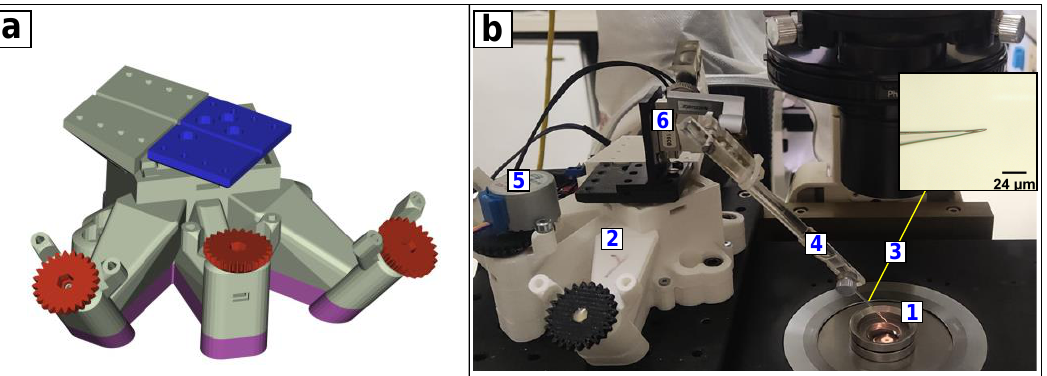
Figure 1. Translation motion stage integrated with microscope set-up for fluorescence calcium imaging. ( a ) Colour-coded CAD of motion translation stage, 3D printed in few parts: a base (purple), a main body (grey), the moving platform (blue) and the actuating screws with knobs (red). ( b ) Cells plated on a glass coverslip held by a steel chamber (1) positioned upon objective of the inverted microscope. The stage (2) enables the driving of Z-axis displacements of the glass probe (3) toward the glass coverslip for single-cell indentation. A micropipette holder (4) is used to hold a glass probe